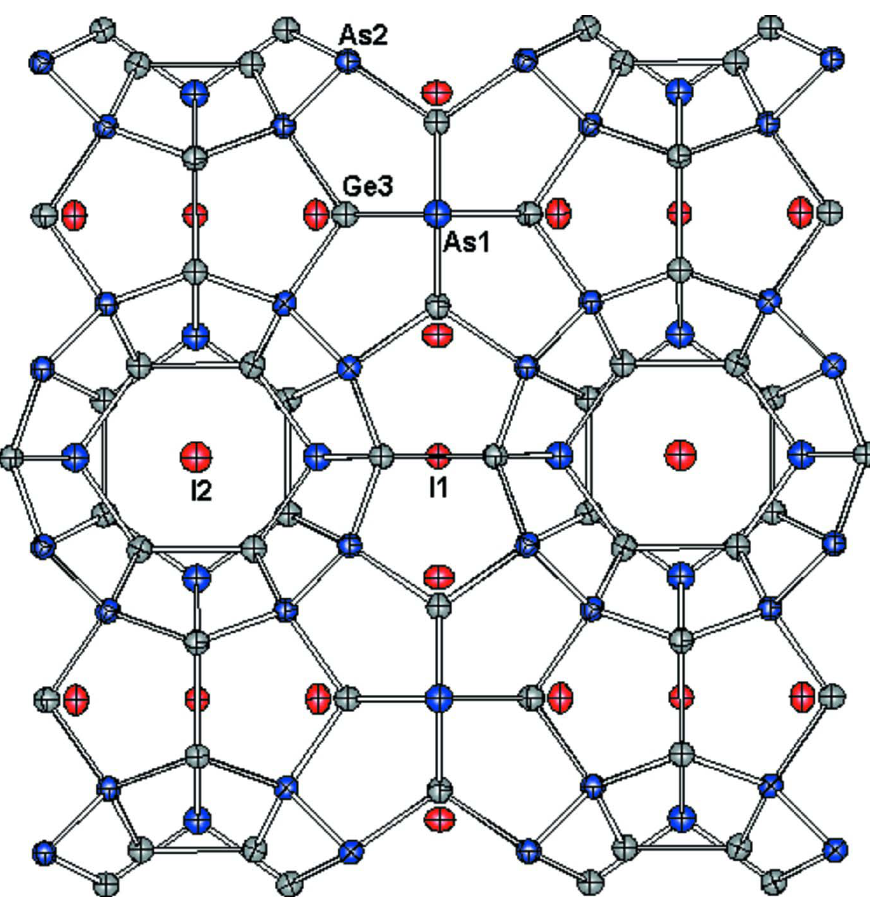
As Ge sur le plan (100) montrant les atomes d′Iode (en rouge); d′Arsenic (en bleu) et de 8 21 25